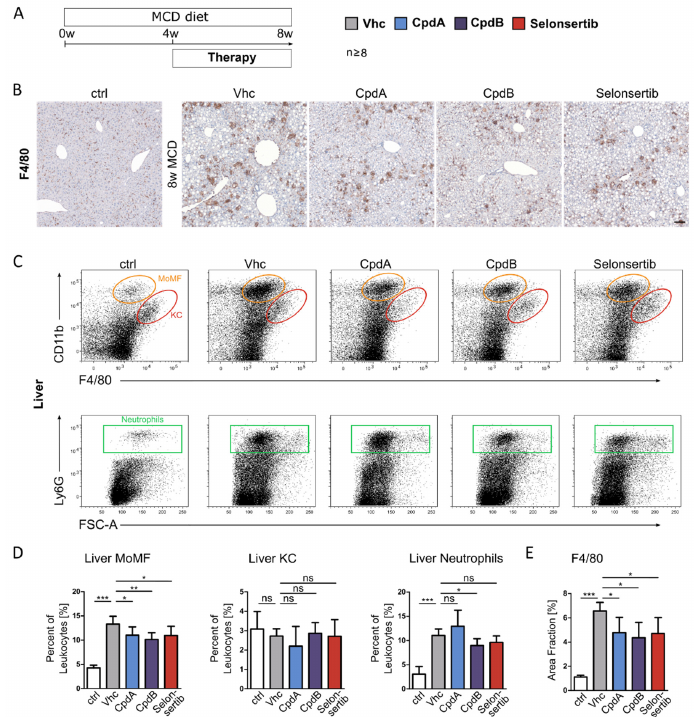
Figure 3. GPR84 inhibition reduces hepatic neutrophil and macrophage accumulation in MCD diet-induced steatohepatitis. ( A ) Mice ( n ≥ 8) were fed with a methionine choline deficient (MCD) diet for a period of 8 weeks. Oral pharmacological therapy was conducted over the last 4 weeks of liver injury induction with the two GPR84 antagonists (30 mg/kg BW, PO q.d.) and selonsertib (15 mg/kg BW, PO b.i.d.) as a positive control. ( B ) Representative pictures of immunohistochemistry staining for the pan-macrophage marker F4/80. ( C ) Representative FACS plots showing CD11b+ F4/80+ hepatic monocyte-derived macrophages (MoMF, orange circle), CD11b+ F4/80++ Kupffer cells (KC, red circle), or Ly6G+ neutrophils (green rectangle). ( D–E ) While the effects on hepatic neutrophils were less pronounced, GPR84 or ASK1 inhibition significantly reduced MoMF numbers (by FACS, D) and F4/80 macrophages (by immunohistochemistry, E). All images were taken at ×10 magnification; scale bar, 100 µm. Data are presented as mean ± SD based on n ≥ 8 per group. * p < 0.05, ** p < 0.01, *** p < 0.001 (one-way ANOVA). Abbreviations: CpdA/B, compound A/B; and Vhc, vehicle.